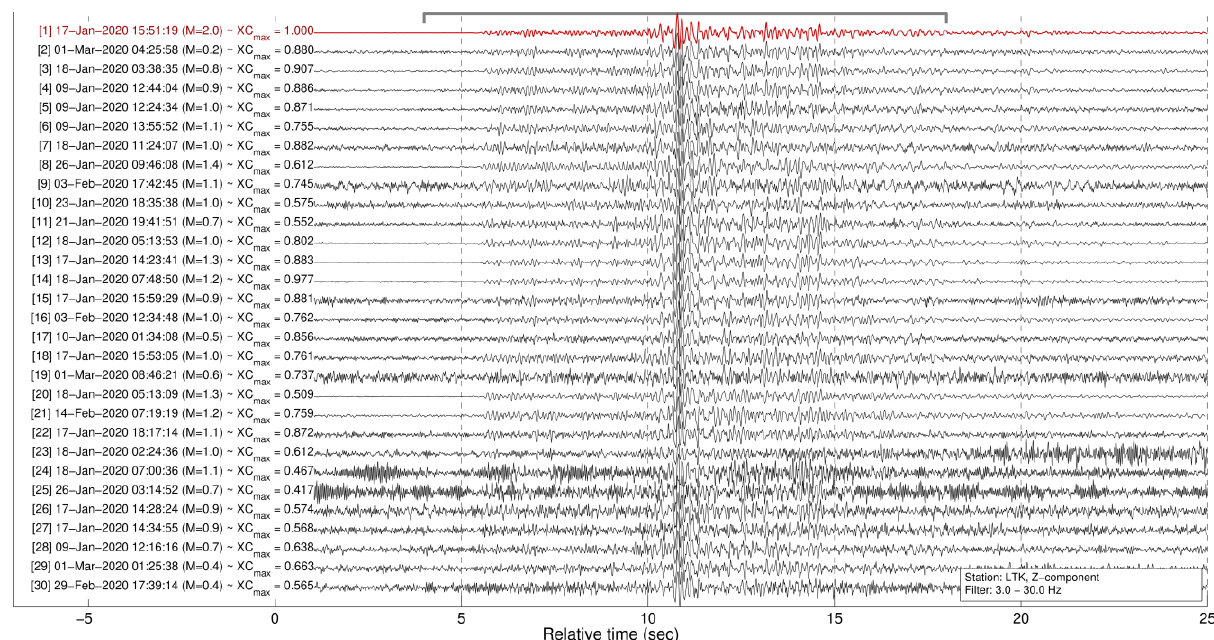
Figure A2. Cumulative number of events per spatial group, represented by different colors and numbers, for a subset of CAT3 containing events with M ≥ 0.5. Circles denote events with M ≥ 2.5. The major events E 1 (7 March 2020, M w = 3.9, in group #2) and E 2 (23 June 2020, M w = 3.7, in group #1) are marked.